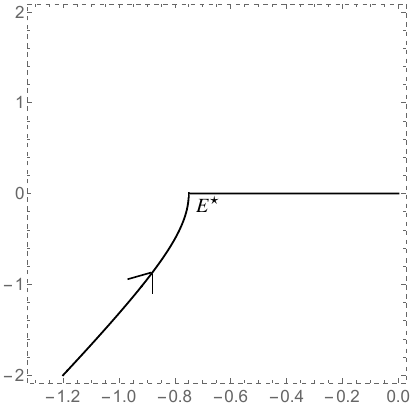
Figure 1 . The contour of integration for the eigenvalues showing that we only need to include “half” of the steepest descent contour for the instanton saddle point. We have shown the numbers for the case p = 3 with κ = 1 but it is qualitatively similar for all p . In string theory, the integration 2 contour for the open string tachyon also looks like